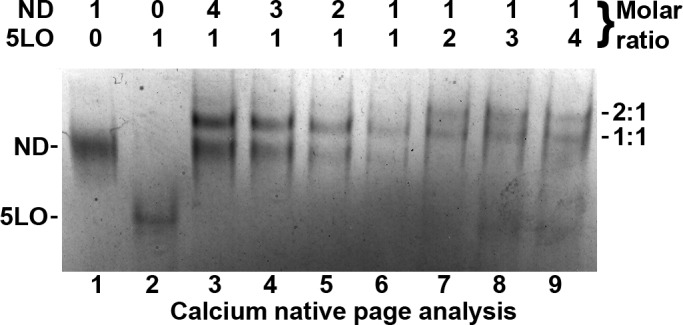
Maximum of two 5LO can bind to one ND.Calcium native PAGE analysis of ND and 5LO incubations in presence of Ca2+, with stoichiometries ranging from 4:1 to 0.25:1 (ND:5LO). From lanes 3 to 5, the concentration of ND is decreasing with constant 5LO. Lane 6, 5LO and ND are in equimolar ratio (0.22 μM). From lanes 7 to 9, the concentration of 5LO is increasing with constant ND. See results for further details.